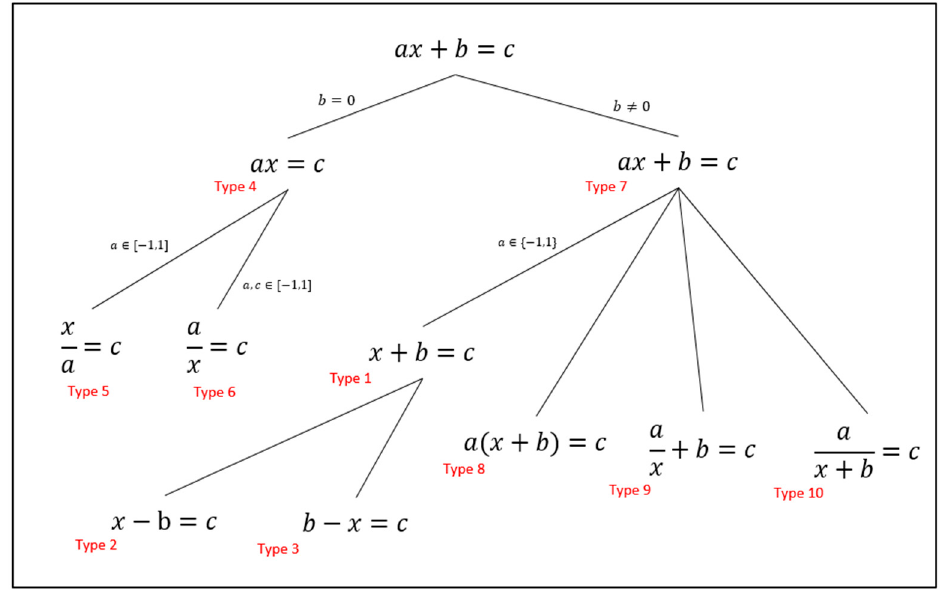
Figure 1. Simplified arithmetical equations.